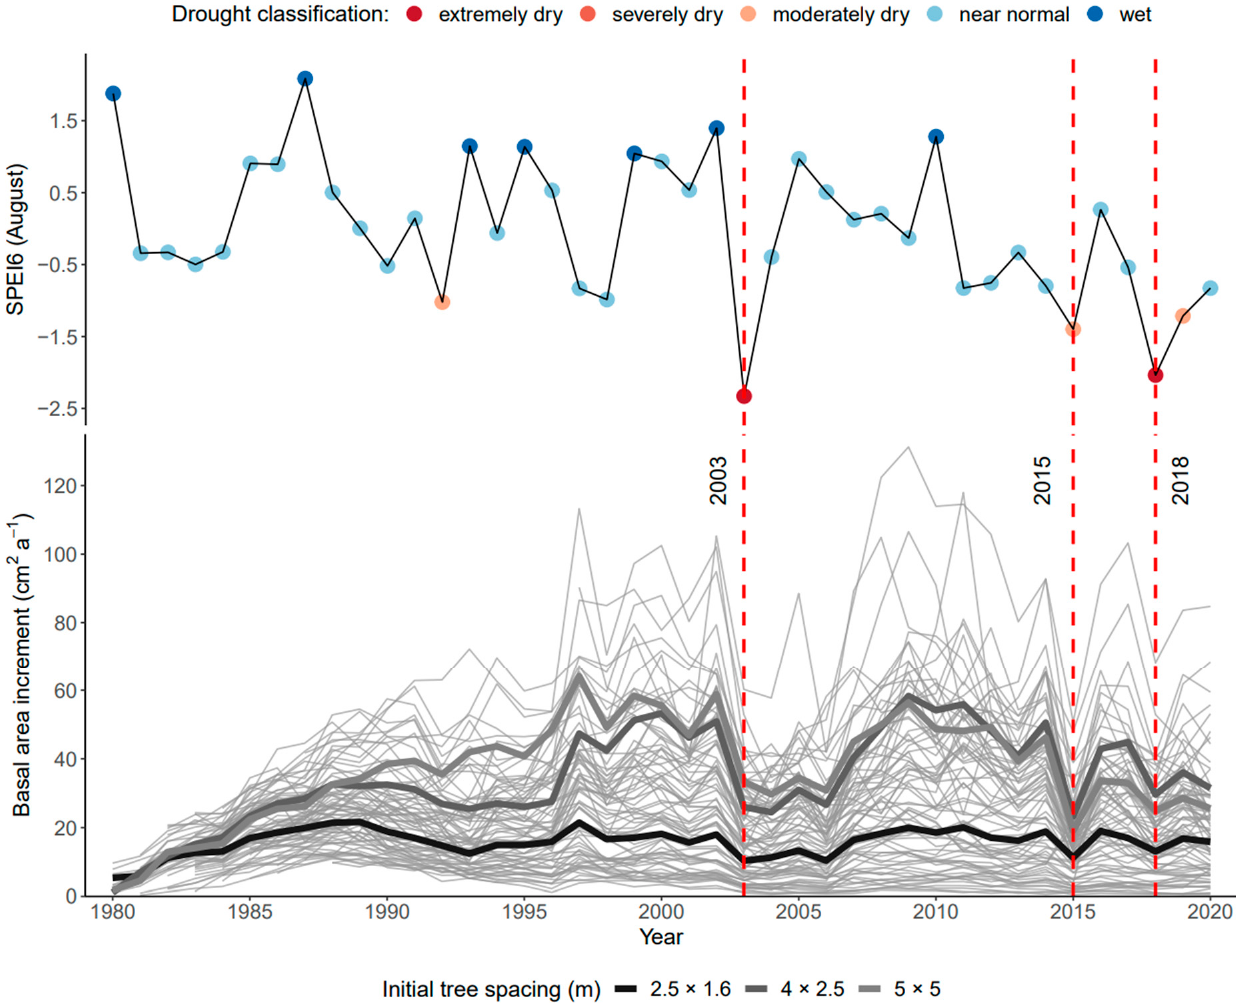
Figure 3. Below, the course of the basal area increment (cm 2 ) of each cored tree ( n = 78) is shown. The bold lines represent the respective averages, whereas the different shades of gray highlight different initial spacing levels. Above, the progression of the SPEI6 in August is illustrated. The color coding refers to the drought classification by Slette et al. [89]. The dotted red lines accentuate the identified drought years based on SPEI6 and pointer years.